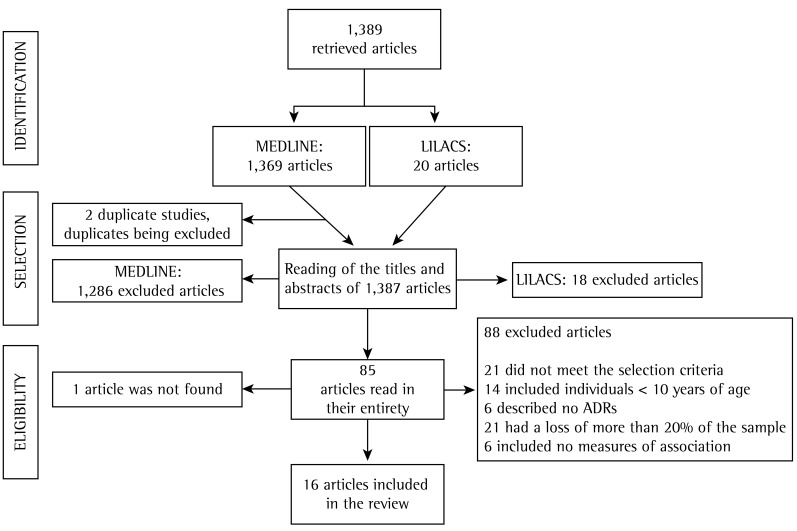
 Flowchart of article selection. ADRs: adverse drug reactions.